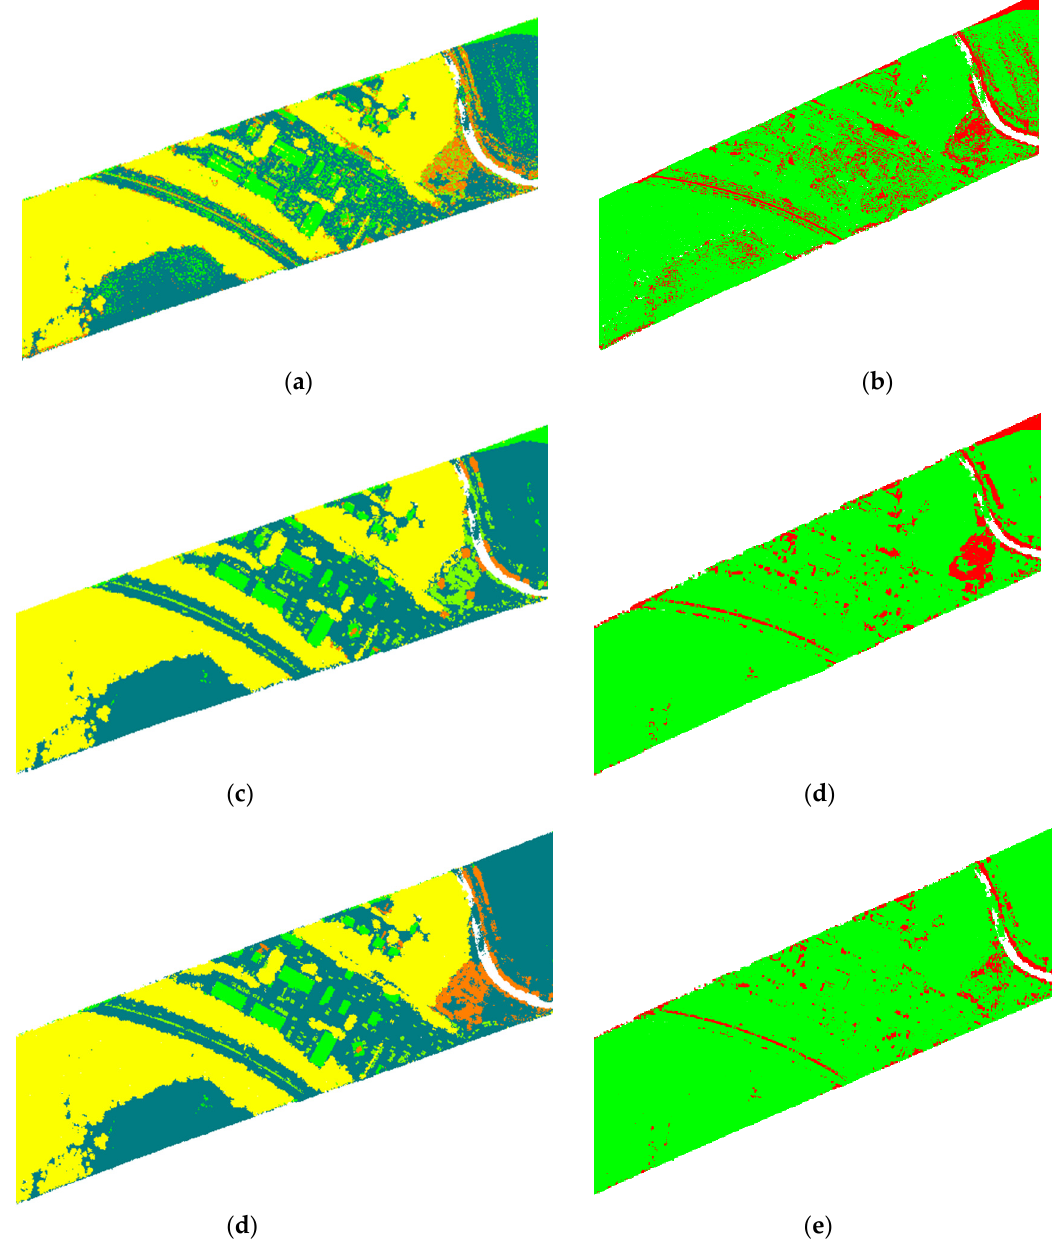
Figure 12. The semantic classification results and classification errors for the GML Dataset A: ( a ) – ( b ) RF; ( c ) – ( d ) CRF; ( e ) – ( f ) LCS-CRF.